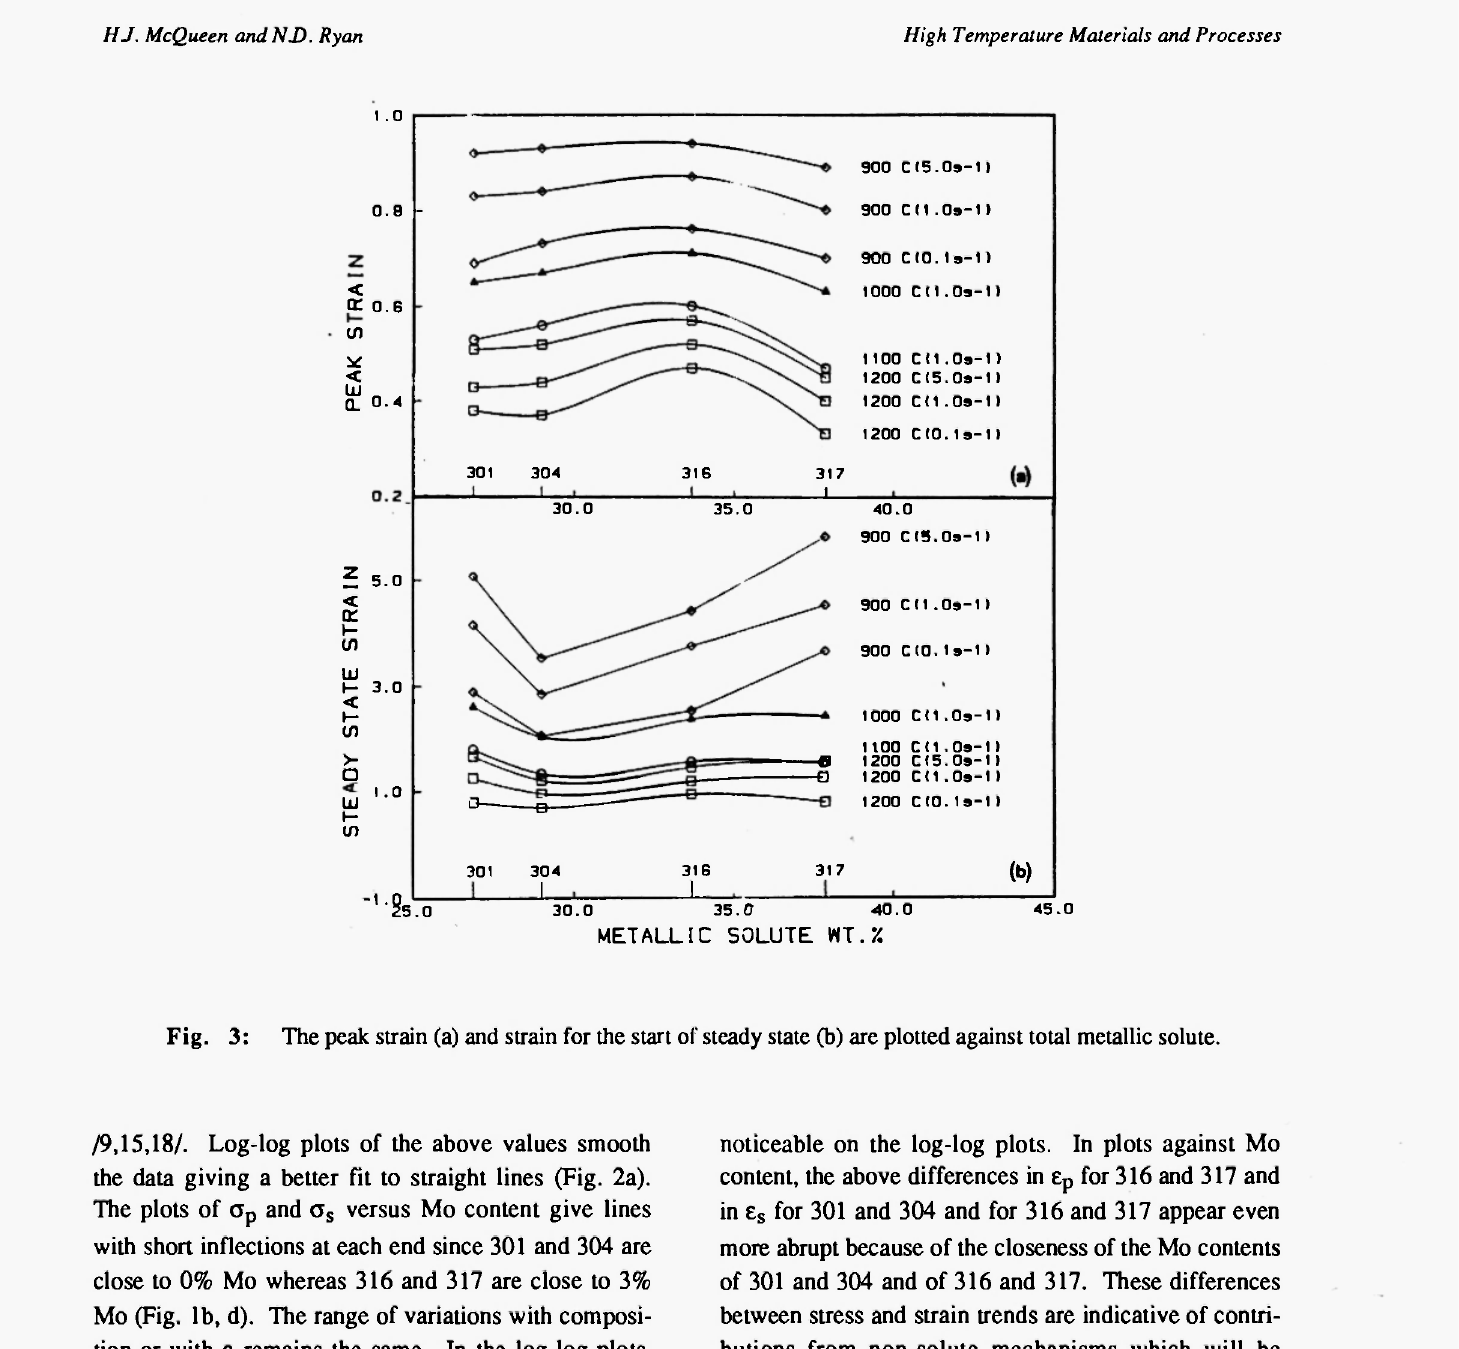
noticeable on the log-log plots. In plots against Mo content, the above differences in ε ρ for 316 and 317 and in ε 5 for 301 and 304 and for 316 and 317 appear even more abrupt because of the closeness of the Mo contents of 301 and 304 and of 316 and 317. These differences between stress and strain trends are indicative of contri- butions from non-solute mechanisms which will be discussed later. The activation energies listed in Table 2 for the worked-homogenized steels /4,7-9,12-18/ are plotted in Fig. 4. Qhw for σ ρ is the highest of the directly calcu- lated values; this relative position could have been